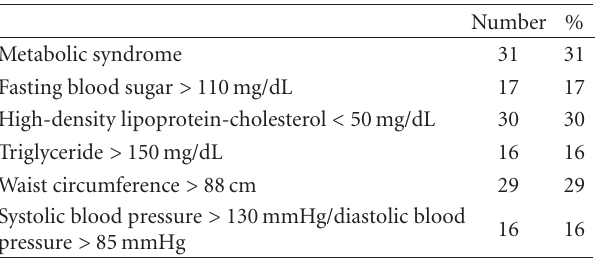
Table 4: Correlation between the anthropometric indices in post- menopausal